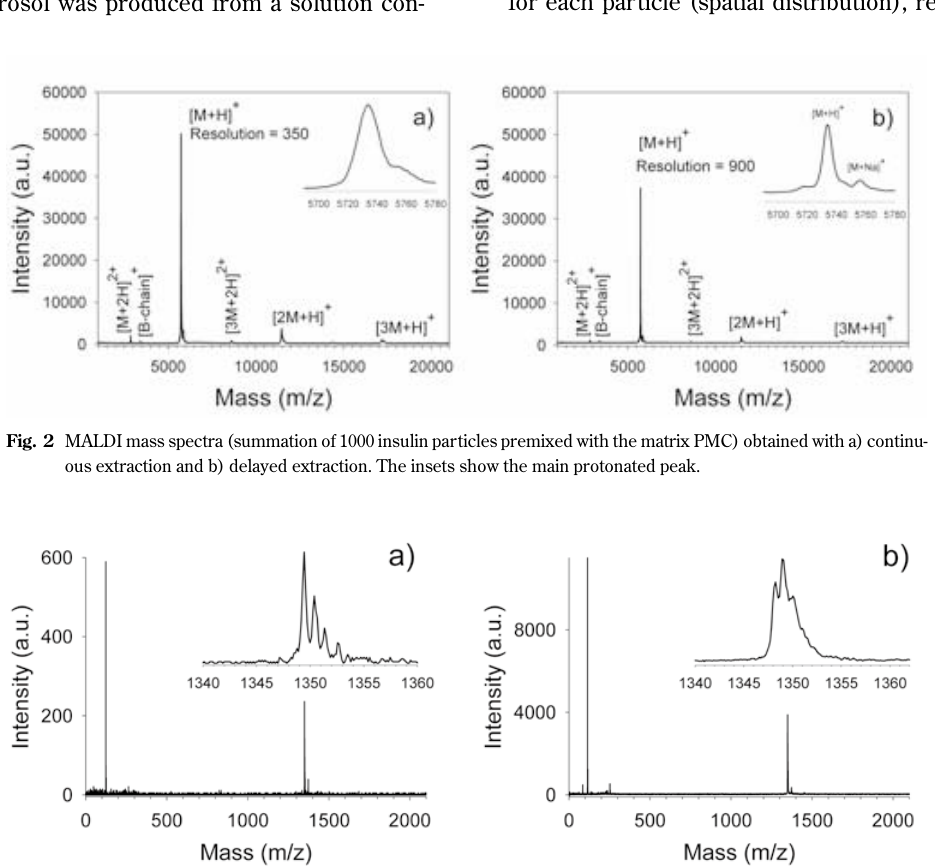
Fig. 3 MALDI mass spectra of aerosol particles consisting of the protein substance P premixed with the matrix PMC; a) single-particle spectrum and b) summation of 50 aerosol particles. The insets show the protonated